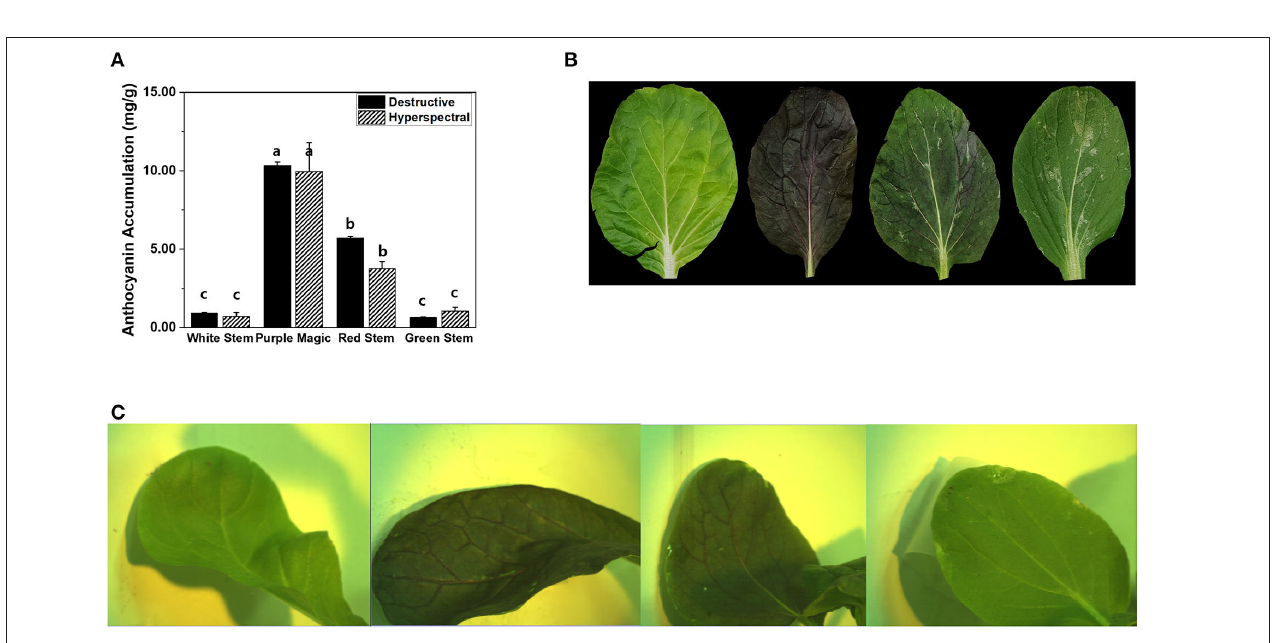
FIGURE 1 | Schematic diagram of hyperspectral imaging employed for target leaf analysis in the first and second experiment (A) , and whole plant analysis in the third experiment (B) .